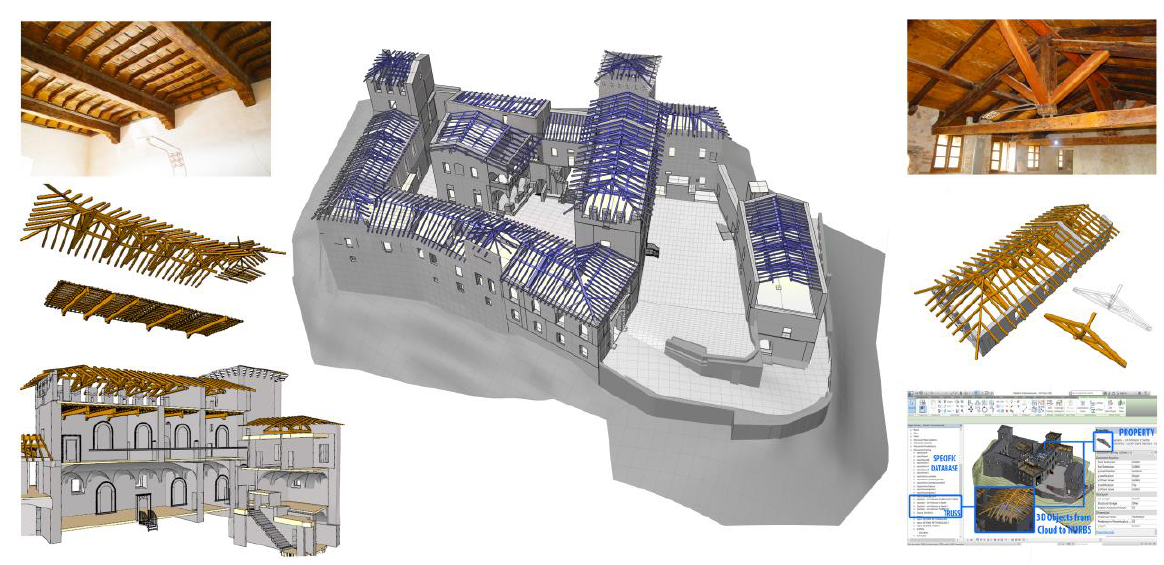
Fig. 4. From NURBS models to BIMS Library. 3D structural elements, wooden beams, truss and joints are enclosed in new database of Masegra Castel in